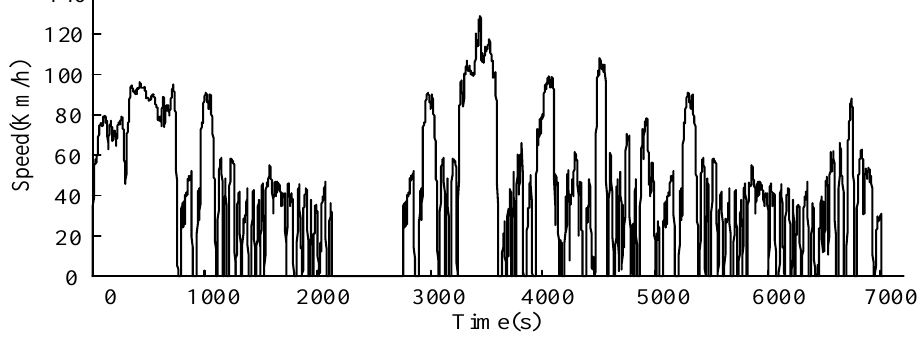
Figure 5. Time-speed relationship of the comprehensive driving cycle. Table 7. Comparison of optimization results.